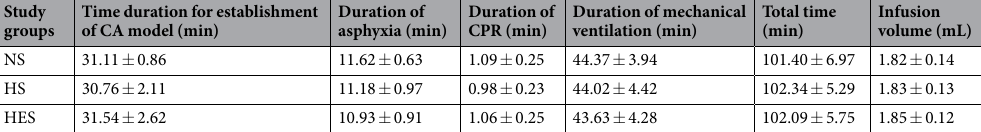
Table 2. Duration of different phases and volume of fluid infused in each phase of the establishment of rat model of CPR.